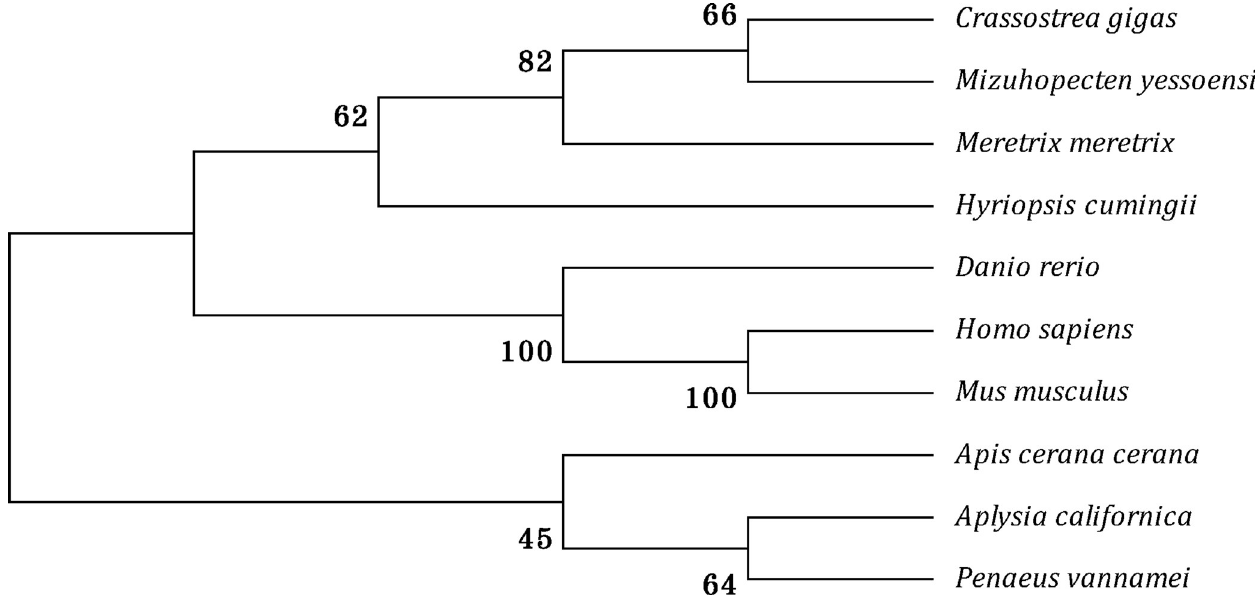
Fig 2. Phylogenetic analysis of HcCPOX from Hyriopsis cumingii and related species. GenBank accession numbers: Crassostrea gigas (EKC32626.1), Mizuhopecten yessoensis (OWF48267.1), Meretrix meretrix (AMY96566.1), Hyriopsis cumingii (KX447817), Danio rerio (NP_001035183.2), Homo sapiens (NP_005247182.1), Mus musculus (NP_031783.2), Apis cerana cerana (PBC27150.1), Aplysia californica (AAP34327.1), and Penaeus vannamei (ROT62892.1). Numbers are the bootstrap values for 1000